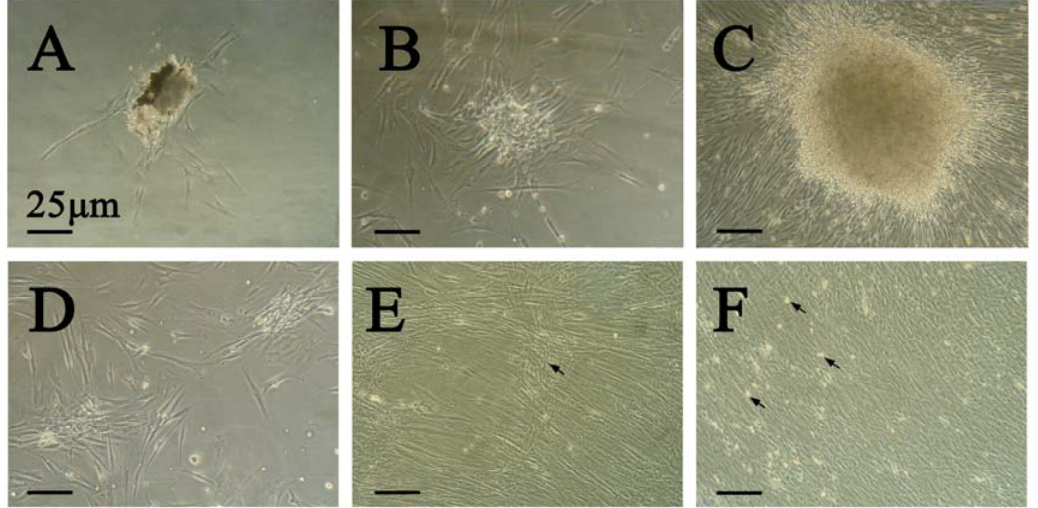
Figure 1. Morphological appearance of DPSCs. (original magnification, ×40). ( A ) The appearance of DPSCs at day 1 of culture. ( B ) DPSCs proliferate as a typical fibroblast-like morphology on day 7. ( C ) Cells started to form an aggregated center with increased extracellular matrix deposition. Generate a large clonogenic cell population after 2 week-culture. ( D ) Proliferation of DPSCs enters an active stage after passaging. ( E ) Formation of hill-and-valley organization (arrows nodules). ( F ) Cells retract and generate multicellular nodules (arrows nodules).